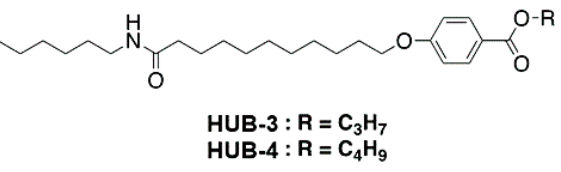
Figure 1. Chemical structure of HUB-3 and HUB-4.